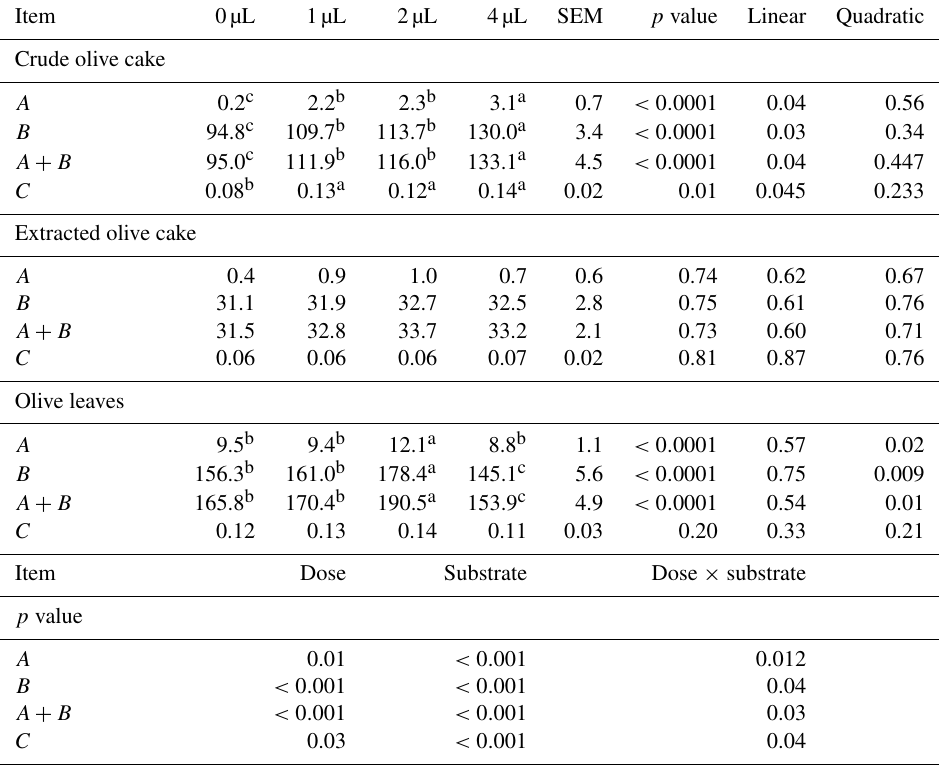
Table 3. Influence of exogenous fibrolytic enzymes on gas production kinetics’ of olive mill